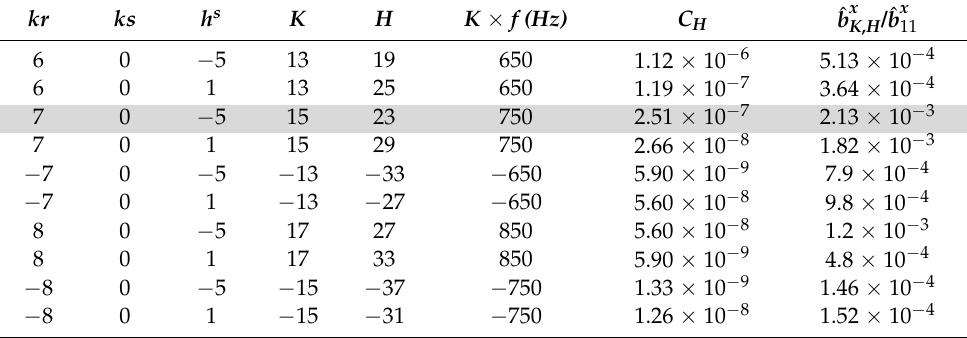
Table 4. Components generated by the faulty synchronous